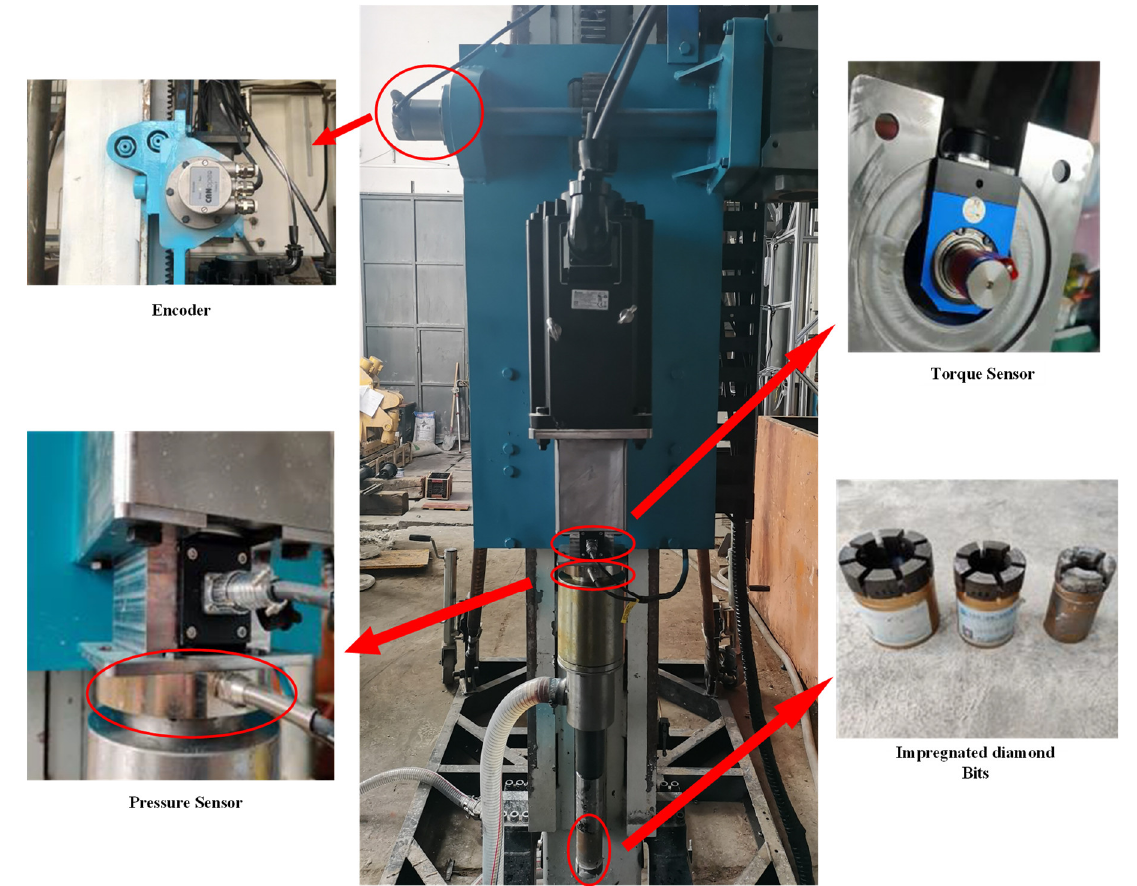
Figure 4. Three sensors in the hoisting system and rotation system.